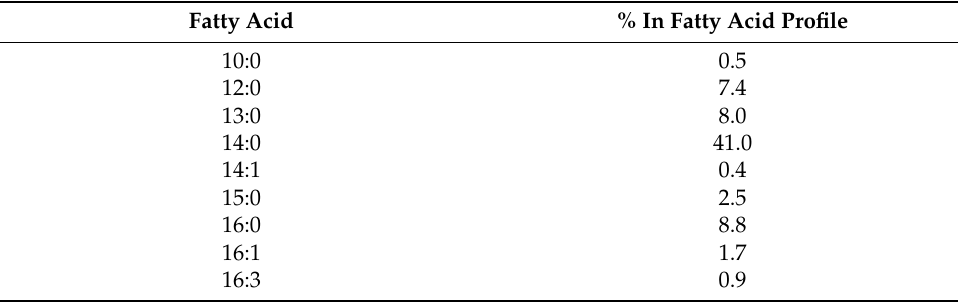
Table 3. Fatty acids profile (%) of Euglena gracilis